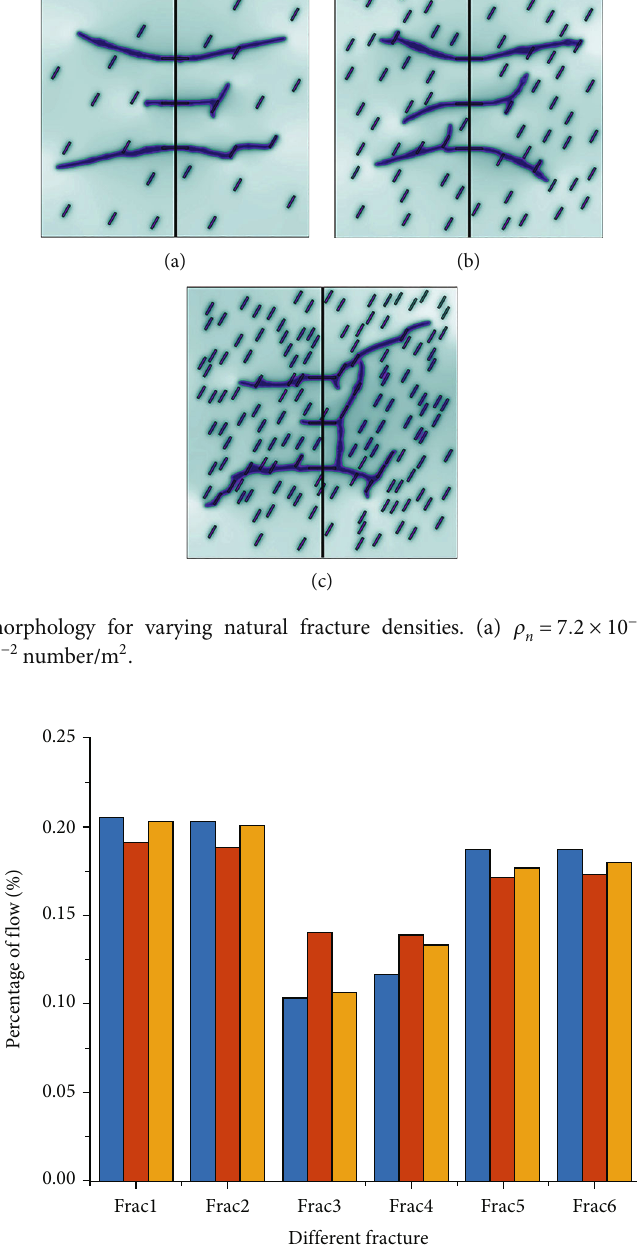
Figure 23: Fluid distribution in fractures for varying natural fracture